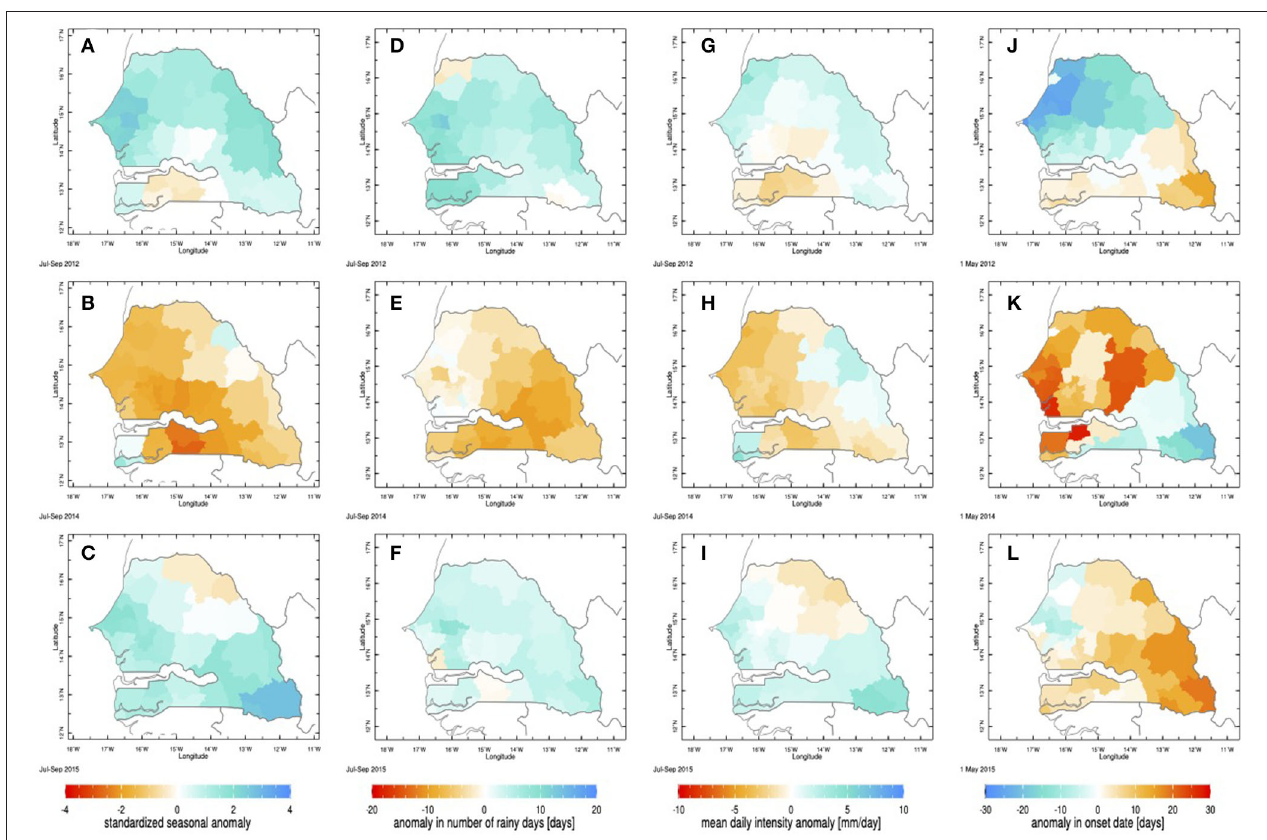
FIGURE 3 | Precipitation anomalies for the rainy seasons immediately preceding the 3 surveys, that is, 2012, 2014, and 2016. Anomalies are computed by subtracting the 20-year average (2000–19) from values in each individual year. The anomalies depicted are in (A–C) total seasonal precipitation (in units of standard deviation), (D–F) number of rainy days (in number of days), (G–I) mean intensity of daily rainfall (in mm/day), and (J–L) onset date (in days, where negative/blue anomalies represent an early onset, and positive/orange anomalies a late onset).